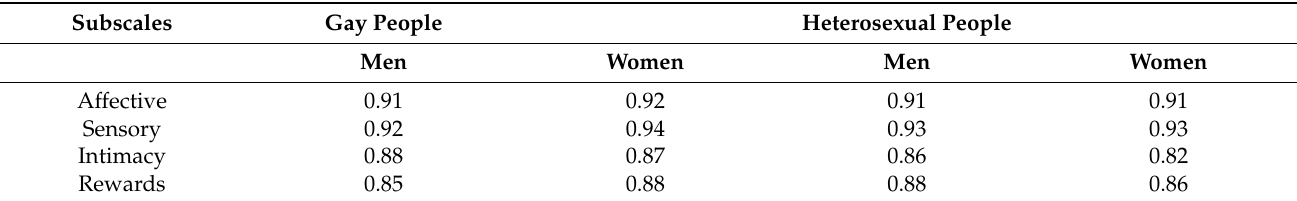
Table 3. Reliability of the ORS subscales.